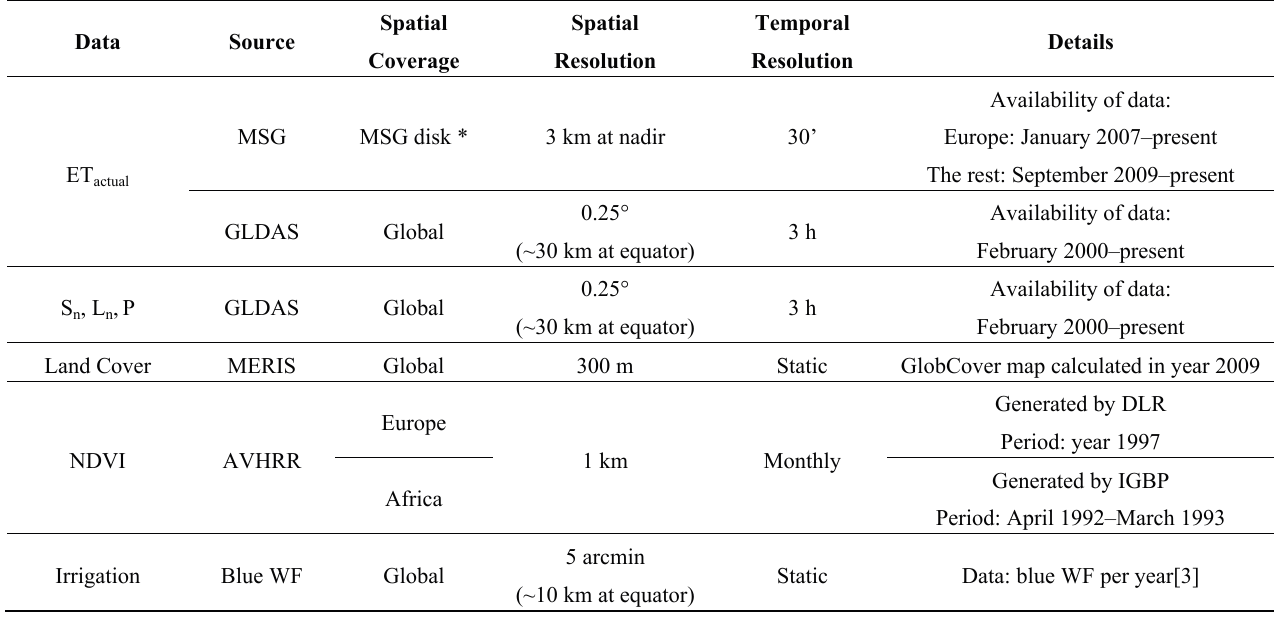
Table 1. Specifications of the data sets used in the present